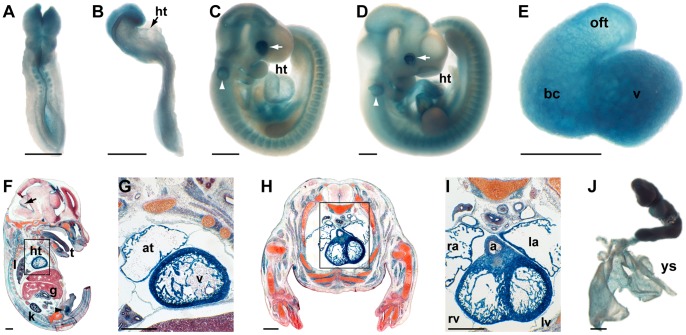
AKAP13 is broadly expressed during mouse development.(A–D) Whole-mount AKAP13+/ΔGEF embryos stained with X-Gal (in blue) to identify AKAP13-βGeo expression at (A&B) E8.5, (C) E9.5, and (D) E10.5. (A&B) E8.5 embryos showed expression in the head folds, notochord, and somites. (C) Right side view of E9.5 embryo showed expression in the heart (ht), brain, eye (arrow), otic pit (arrowhead), gut, and somites. (D) Right side view of E10.5 embryo showed similar expression as in (C) with higher expression in the heart (ht). (E) Frontal view of an E10.5 heart showed high levels of expression in the ventricle (v), bulbous cordis (bc), and outflow tract (oft). (F) Sagittal and (H) transverse sections of E14.5 embryos stained with X-Gal and nucleofast red. E14.5 embryos showed expression in the heart (ht), tongue (t), lung (l), gut (g), kidney (k), skeletal muscle, brain (arrow), and urogenital region (arrowhead). (G&I) Close ups of the hearts boxed in F and H, respectively, showed expression in atrial (at), and ventricular (v) myocardium, endocardium and trabeculae. The right and left atria (ra & la) and ventricles (rv & lv) all showed expression with higher levels in the left ventricle (lv). There was also expression in the aorta (a). (J) X-Gal staining of E9.5 embryos with the yolk sac attached showed expression in the yolk sac (ys). Black scale bars are 0.5 mm.